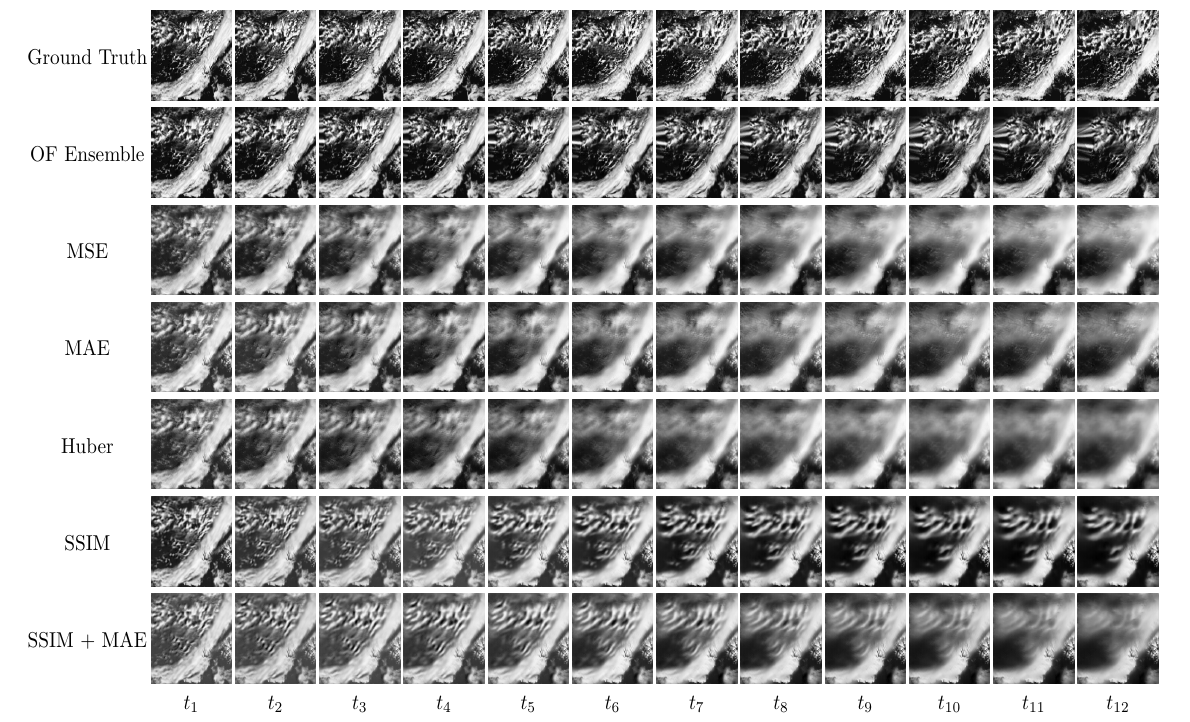
Figure 5. An example 3 h nowcast (12 frames) over France on 17 March 2019, contrasting the ensemble optical flow model and ConvGRU-based nowcasting models trained with different loss functions against the ground truth sequence, with t n representing each 15 min time step. Here, the OF ensemble is the worst performing model, with the best performing model being the SSIM